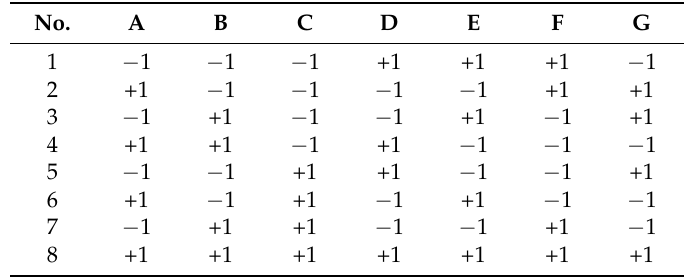
) matrix consisting of eight experiments and III